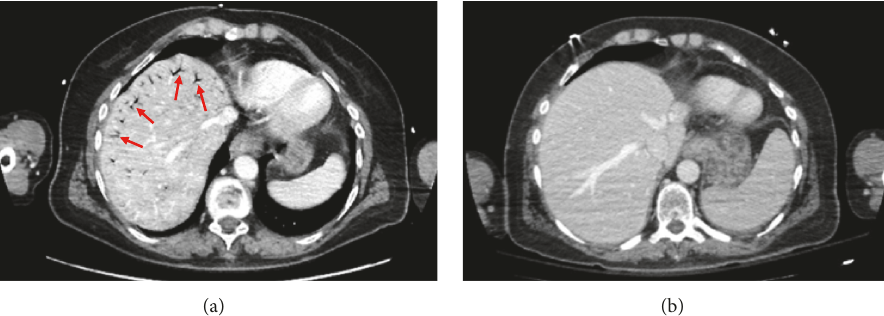
Figure 2: Abdominal CT scan: (a) GE in the peripheral branch of the portal system after HP ingestion; (b) reduction of the GE after HBOT.